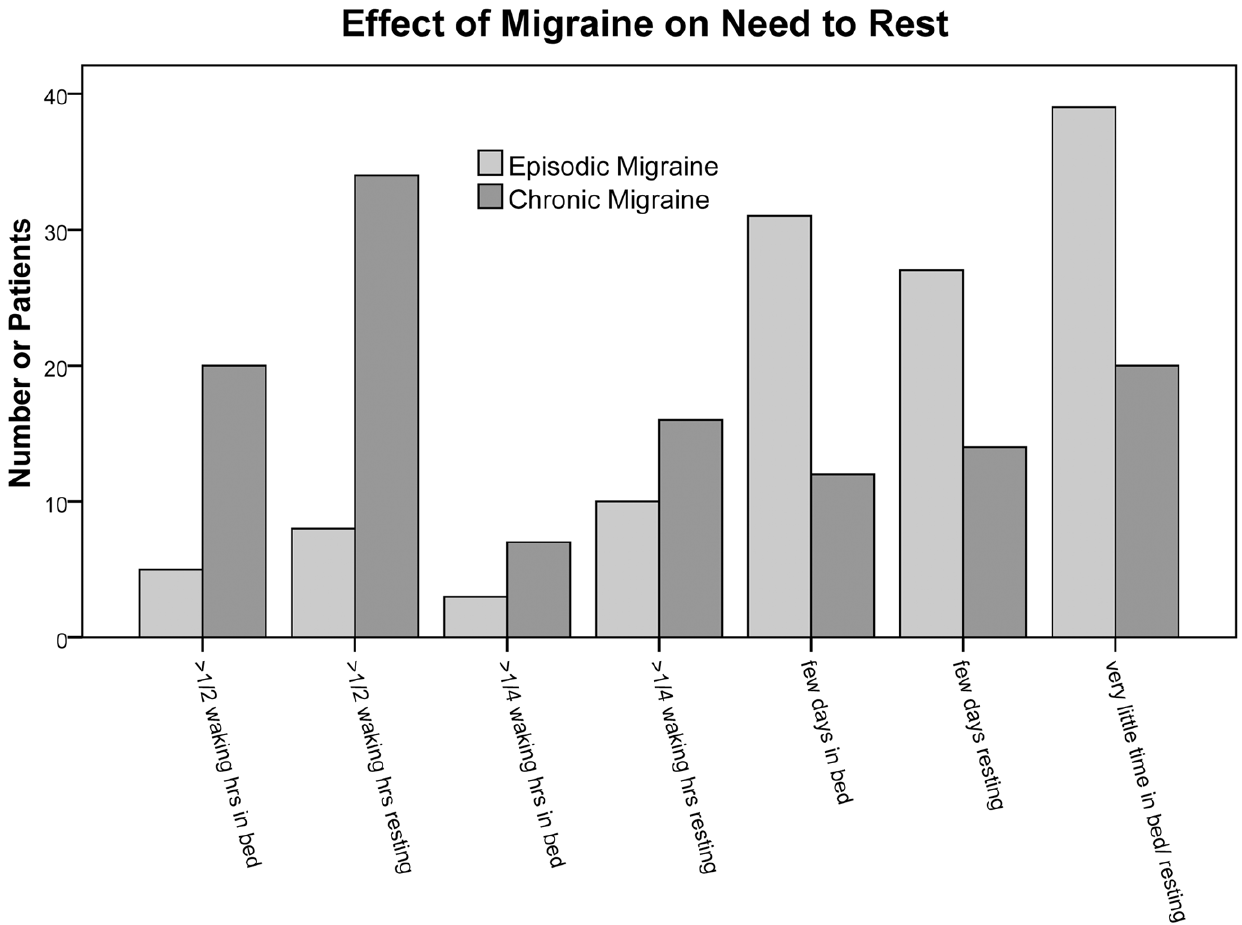
Figure 2. Effect on Need to Rest. Distribution of answers to questionnaire on the effect of migraine on need to rest and spending time in bed. Subjects with chronic migraine reported spending more time in bed and resting (p , 0.001, Krushal-Wallis test).